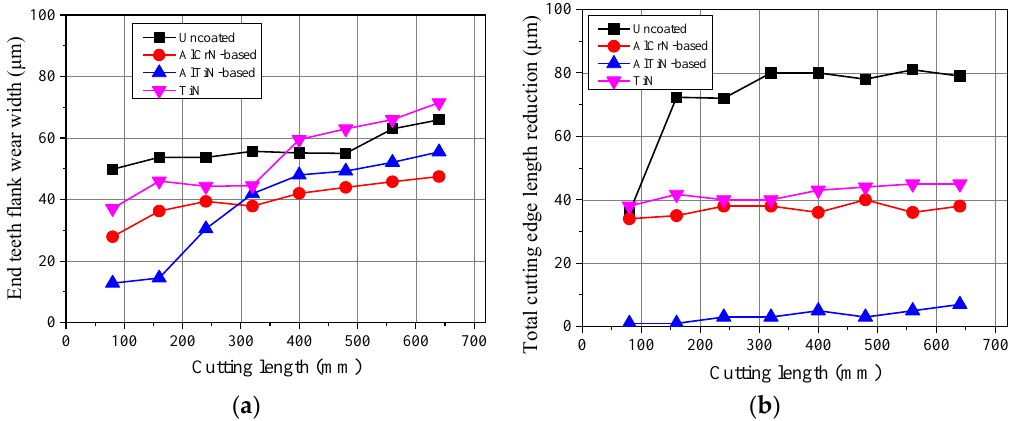
Figure 5. End teeth flank wear length and total cutting edge length reduction of micro end mills with different coatings ( v c = 20 m/min, f z = 2 µ m/z, a p = 50 µ m). ( a ) End teeth flank wear length; ( b ) Total cutting edge length reduction.